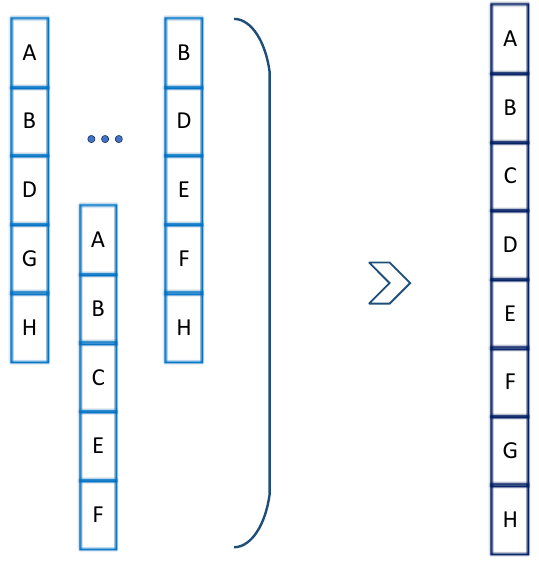
Figure 2. Technical scheme of the synthetic stratigraphic sequence of Quaternary strata.